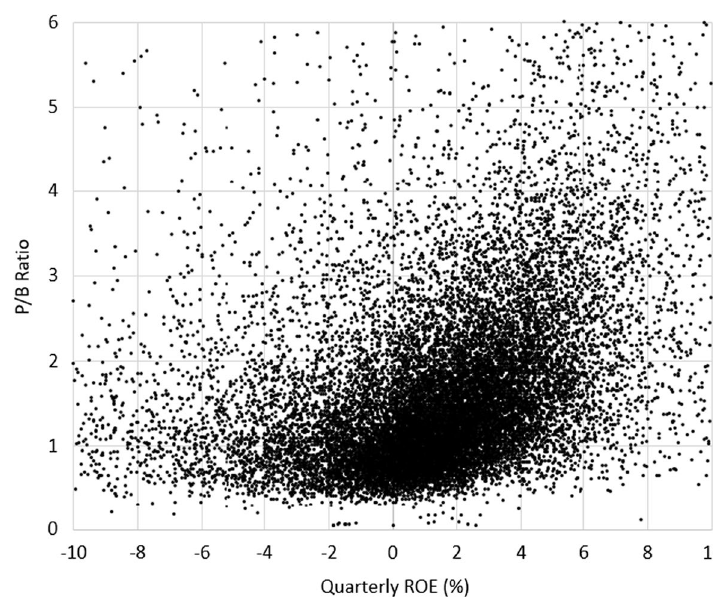
Fig. 3 ROE and P/B scatter diagram of Taiwan stock market